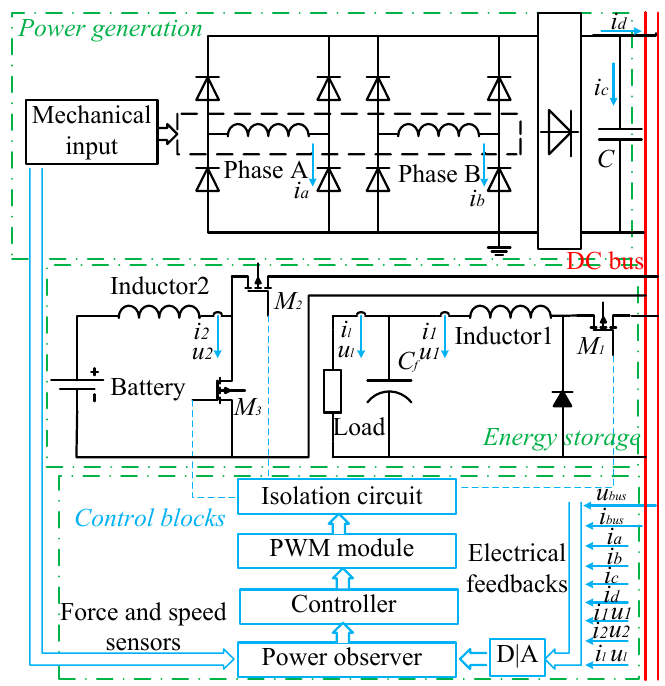
Figure 3. Topology of the power generation and storage system.